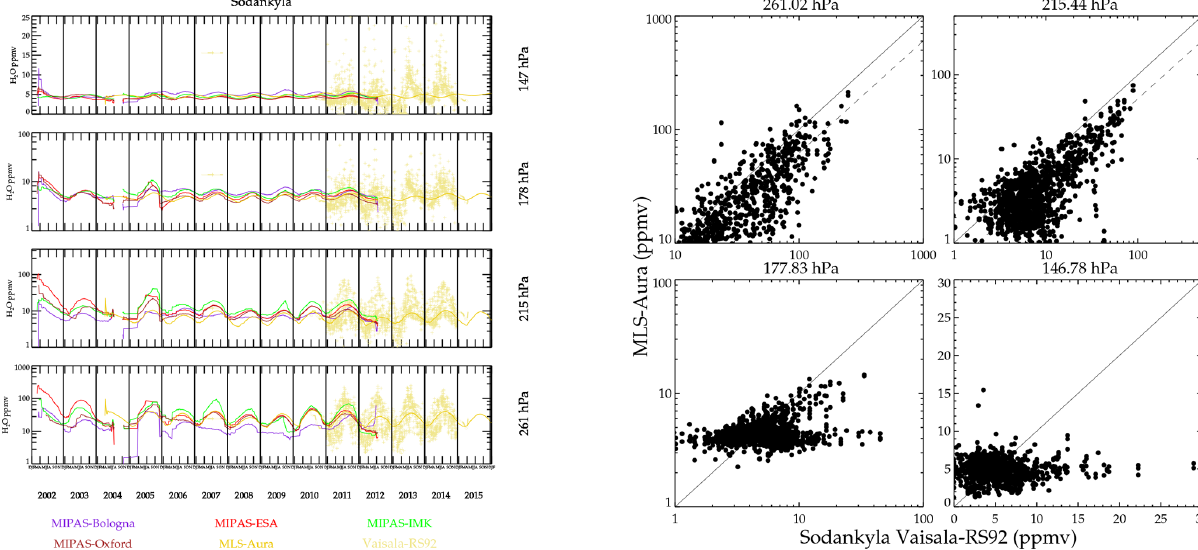
Figure 16. Smoothed time series (left) and scatter plot (right) comparing Vaisala RS92 hygrometer versus satellite instrument and retrievals at Sodankylä,